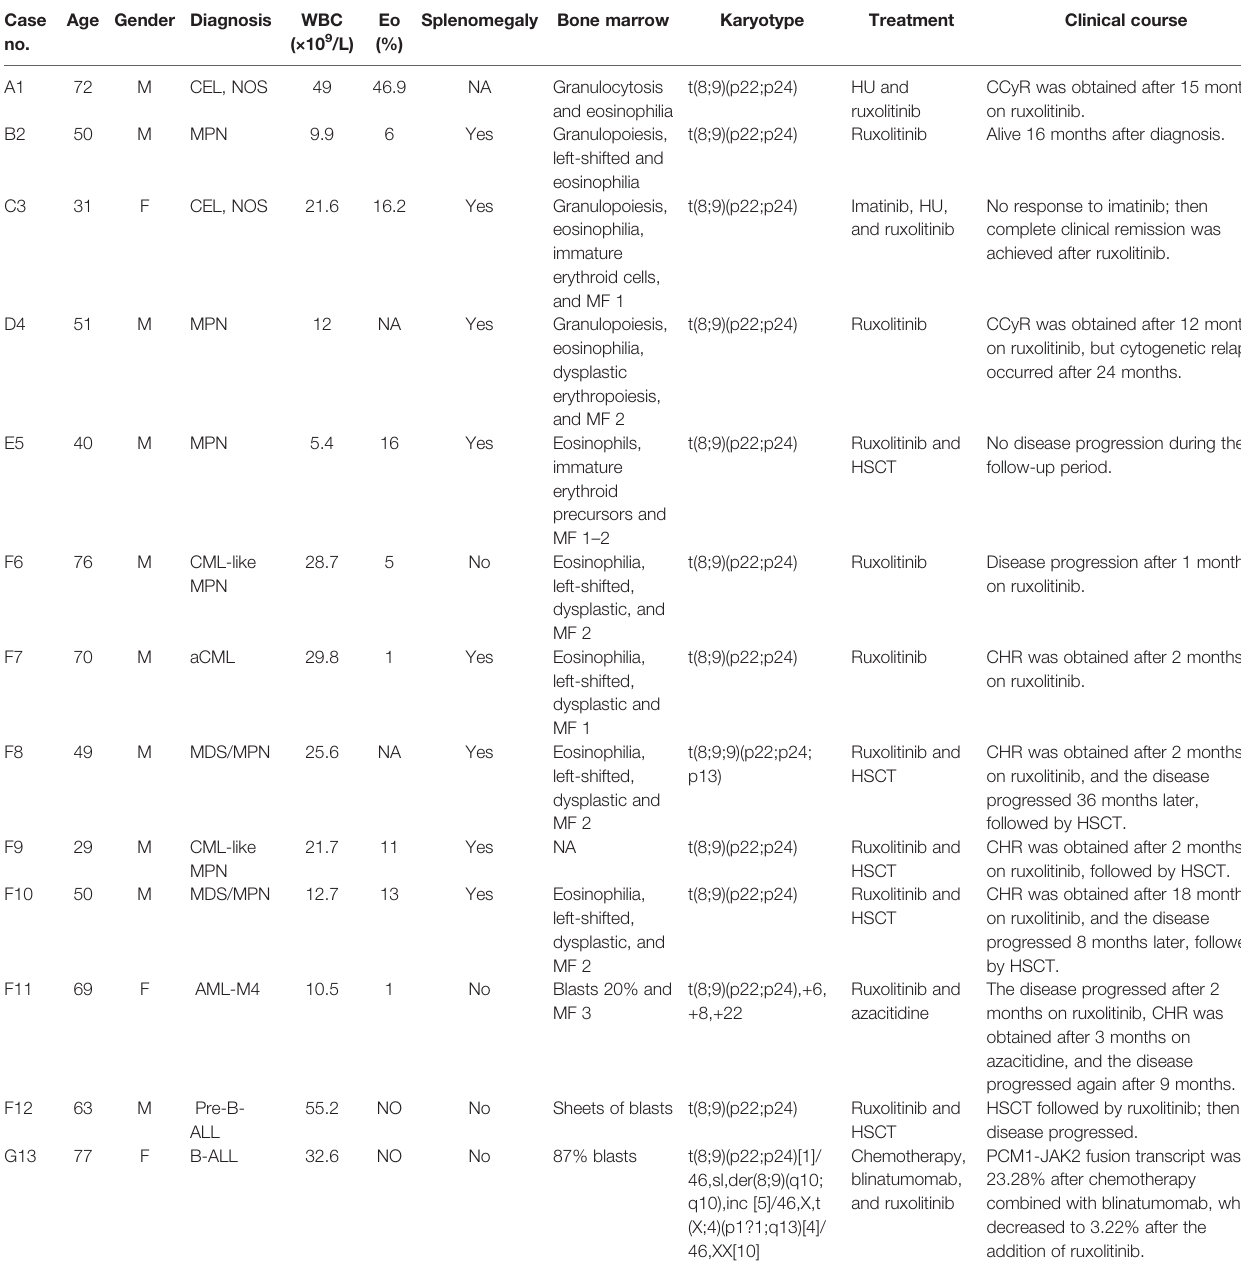
TABLE 2 | Clinical characteristics of hematological neoplasms patients with PCM1-JAK2 rearrangement treated with ruxolitinib in the literature. Case